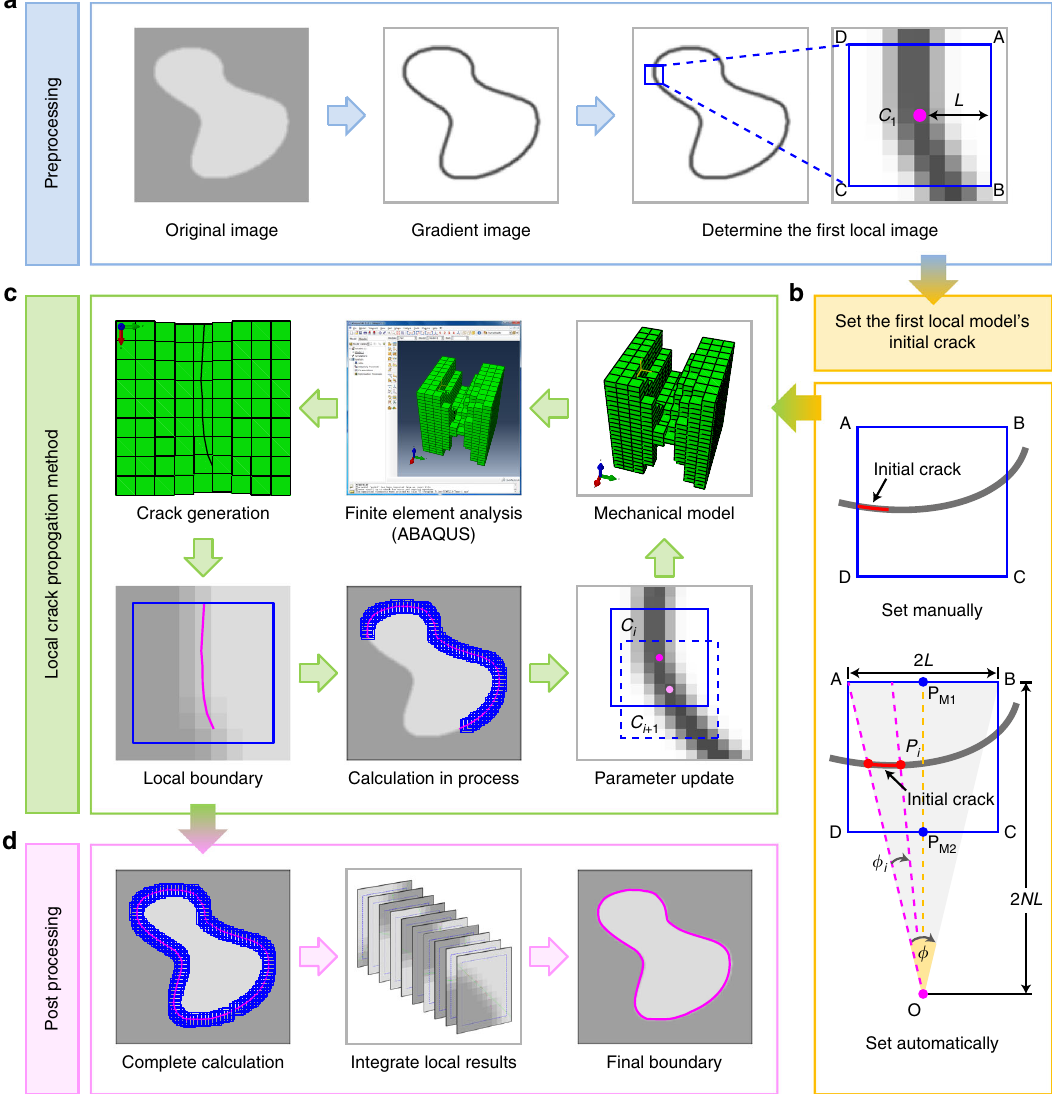
Fig. 10 Pipeline of the local crack-propagation method algorithm. a Preprocessing (blue box): Import the segmentation image and obtain the corresponding grayscale-gradient image. Determine the center C 1 of the initial partial image and the size of the local model 2 L . b Set the initial crack (yellow box) in the fi rst local model manually (top half) or automatically (bottom half). c Local crack-propagation method (green box): establish the mechanical model based on the local image, set parameters, and boundary conditions of the fi nite-element analysis (FEA). Call FEA software ABAQUS to simulate crack propagation. Obtain the crack generated in the model. Calculate the local boundary in the partial image according to the crack. If the crack calculation of the entire image has not been completed, determine the next local model center C i + 1 based on the current center C i and the crack direction, and then establish the new local model to continue the crack propagation. d Post processing (pink box): After completing the crack calculation for the entire target area, integrate cracks generated in all local models to obtain the complete image